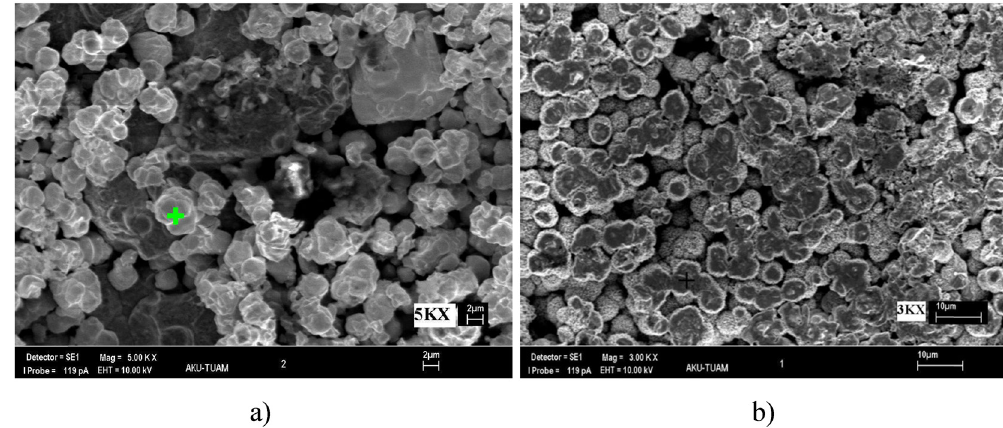
Figure 1: SEM pictures before and after coating. ( a ) SEM of uncoated powders and ( b ) SEM of coated